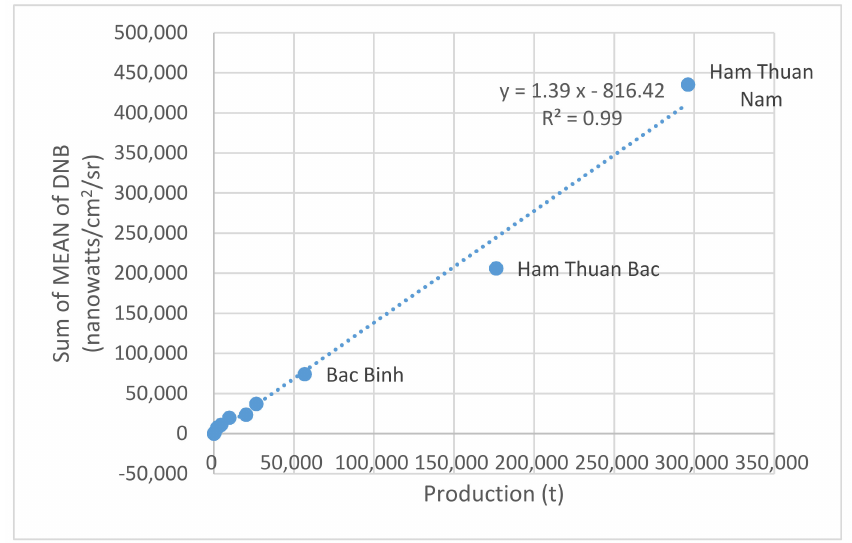
Figure 9. Pearson correlation between the sum of mean and the production of dragon fruit.